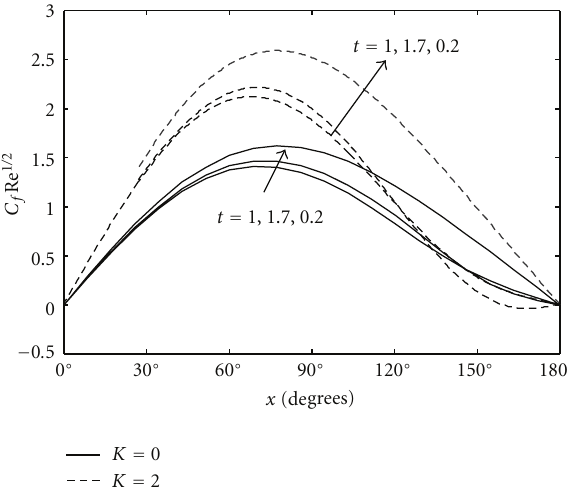
Figure 6: Variation of the skin friction coe ffi cient with x for K = 2 and for various values of t when Pr = 1, α = − 1 (opposing flow) and n = 1 / 2.